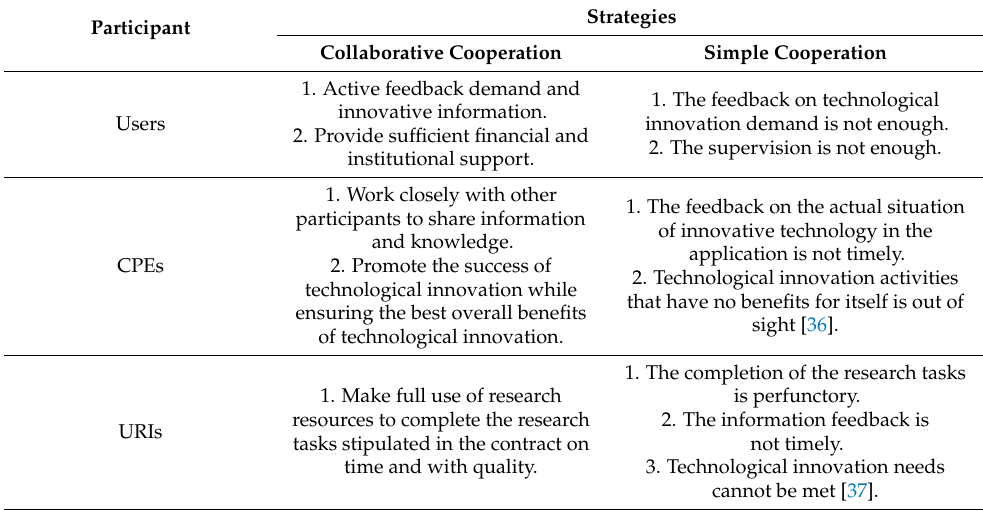
Table 1. Specific performance of the different strategies among the Users, the CPEs, and the URIs.